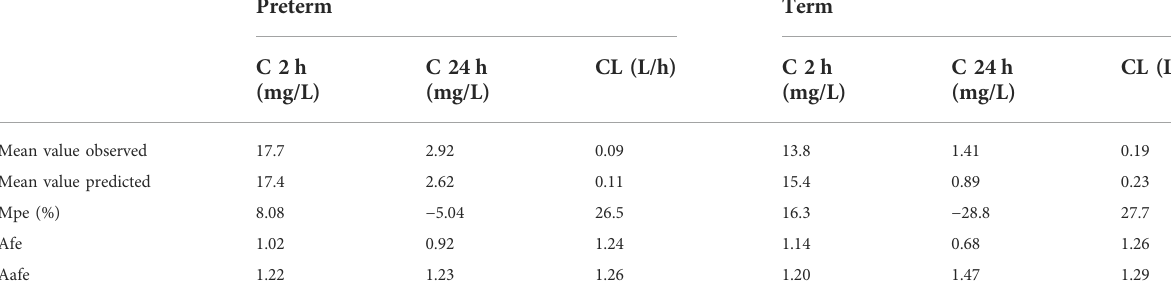
TABLE 4 Mean values and precision and bias errors of gentamicin minimal PBPK model developed.